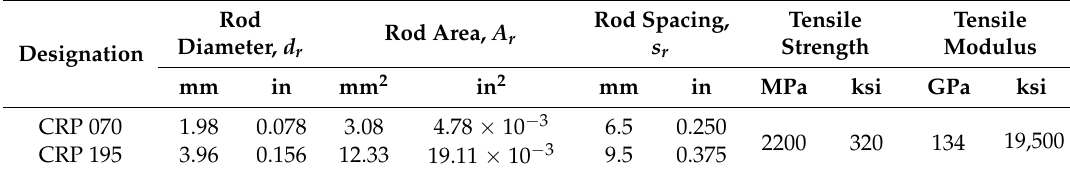
Figure 1. CFRP Rod Panels (CRPs) with finger joint. Table 1. CFRP Rod Panel (CRP) properties for two different rod